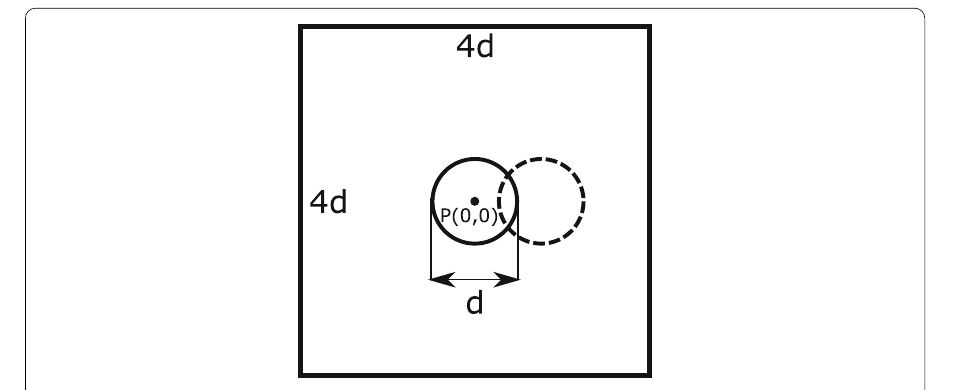
Fig. 11 Sketch of domain with cylinder, the non-moving cylinder (solid line) is located at the center and the moving cylinder (dashed line) is initially shifted slightly to the right